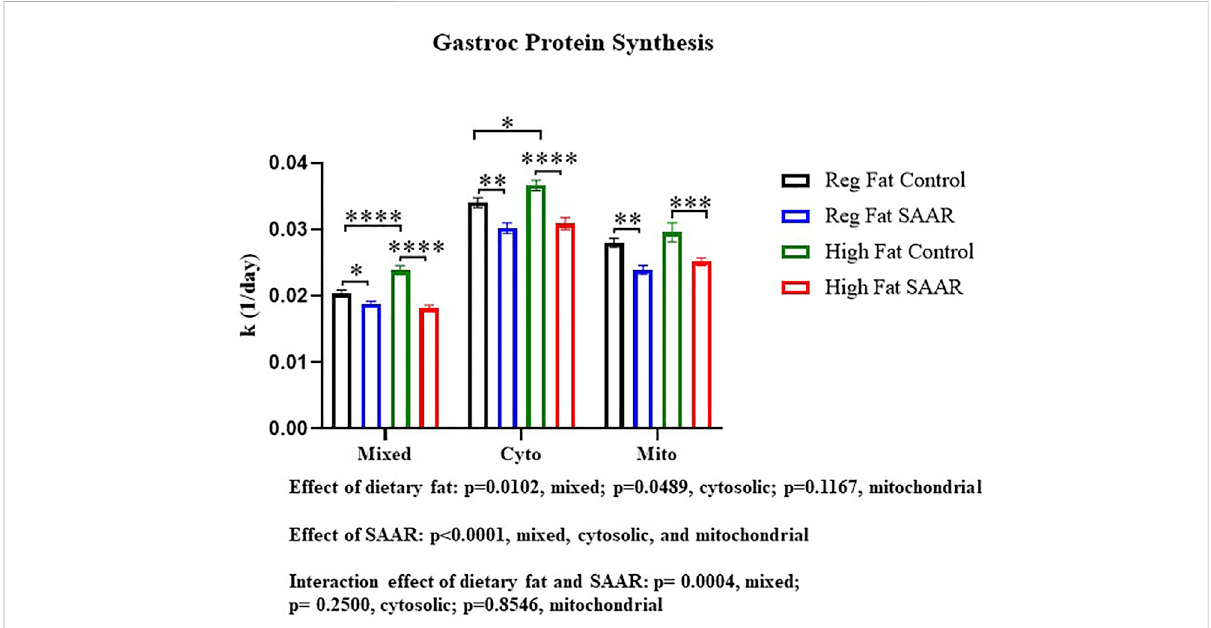
FIGURE 2 Rates of protein synthesis in gastrocnemius were measured in mice fed Regular Fat Control, Regular Fat SAAR, High Fat Control, or High Fat SAARdietsfor1,3,7,14,21,and35 days.A1-phaseassociationwasusedtocalculatetherateoftheriseoffractionnewproteinsynthesizedovertime, to determine the rate of synthesis (k, 1/d). There was a signi fi cant main effect of SAAR in the mixed, cytosolic, and mitochondrial protein fractions. Additionally, there was a signi fi cant main effect of dietary fat in the mixed and cytosolic fractions. The Interaction was signi fi cant in the mixed proteinfractiononly.Post hocmultiplecomparisonsshowed that micefedeither oftheSAARdiets hadsigni fi cantly slower ratesofmixed,cytosolic, and mitochondrial proteins compared to the respective control diets. Additionally, rates of mixed and cytosolic protein synthesis were signi fi cantly differentbetweentheRegular FatControland High FatControldiets.Dataare presented asmeans± SEM( n =14 – 20); mixed andcytosolic fractions excluded day 1 and 3 ( n = 3/day) due to low alanine deuterium enrichment. * p < 0.05, ** p < 0.01, *** p < 0.001, **** p < 0.0001. SAAR diets are compared to their respective SAA suf fi cient control